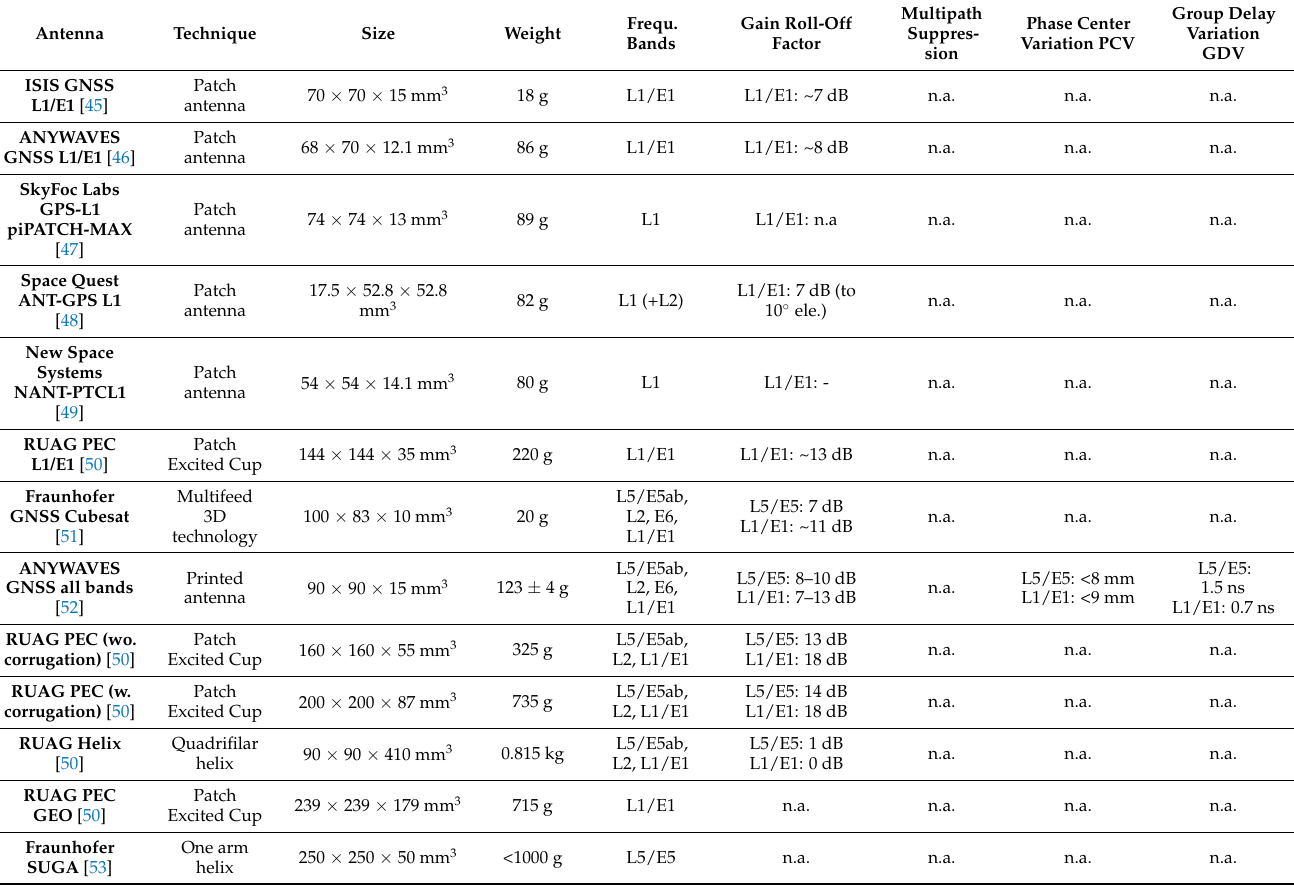
Table 2. Comparison of GNSS Rx antennas for space